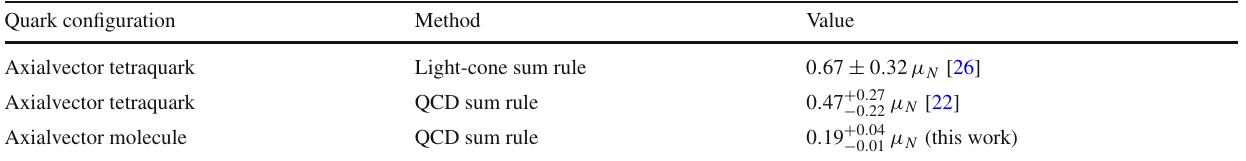
μ N [22] 0 . 22 μ N (this 0 . 01